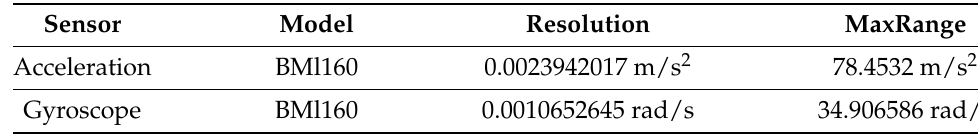
Table 1. The Parameters of Sensor.